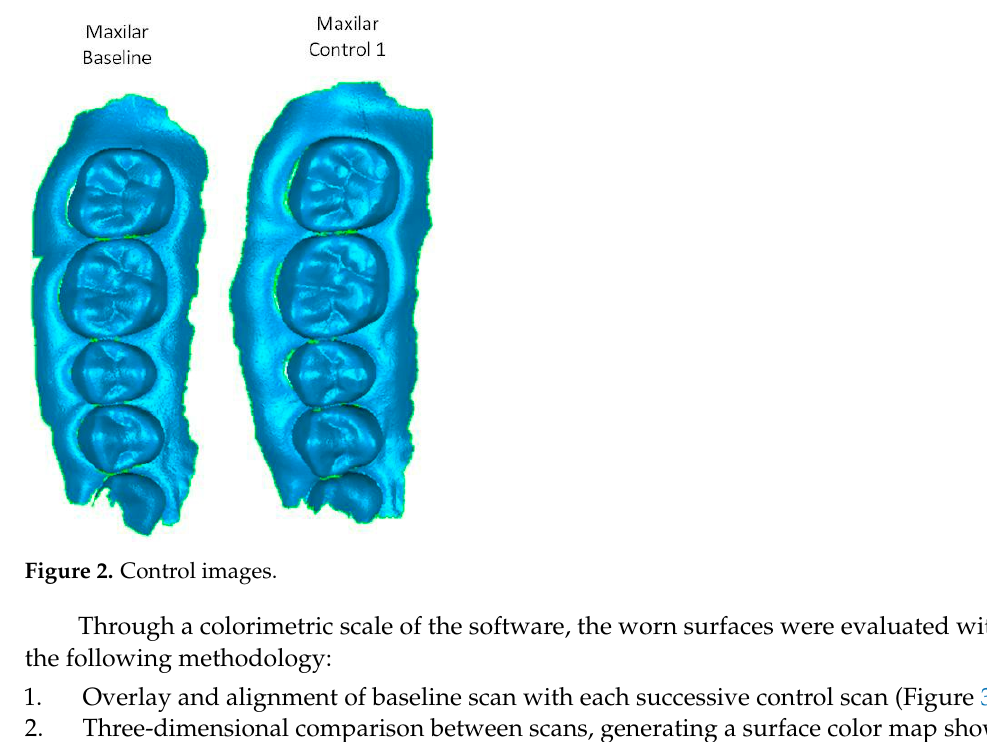
5 of 15 Figure 1. Flow chart of data collection.